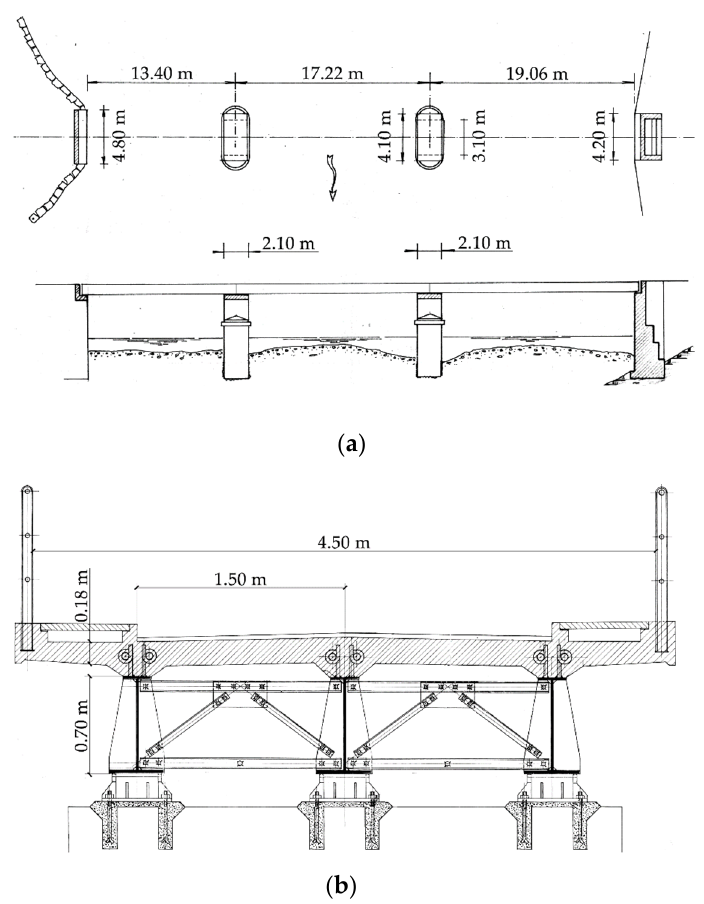
Figure 2. Original blueprints of Baghetto Bridge: ( a ) plan and longitudinal section; ( b ) detail of the steel–concrete composite deck.